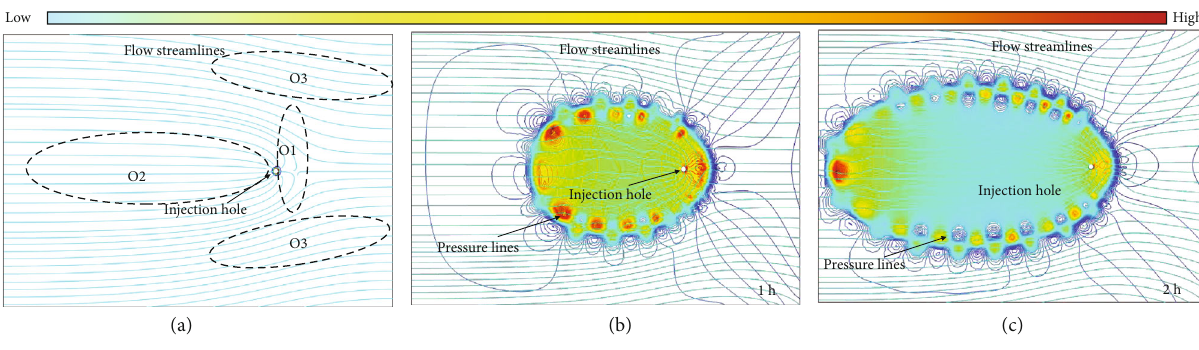
Figure 8: Grout pressure and streamlines in